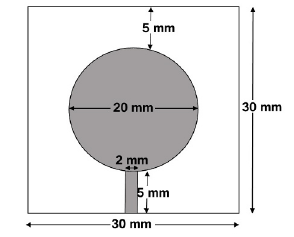
affect the application of antennas in modern wireless com- munication systems. Microstrip antenna for applications such as mobile and other portable devices must be